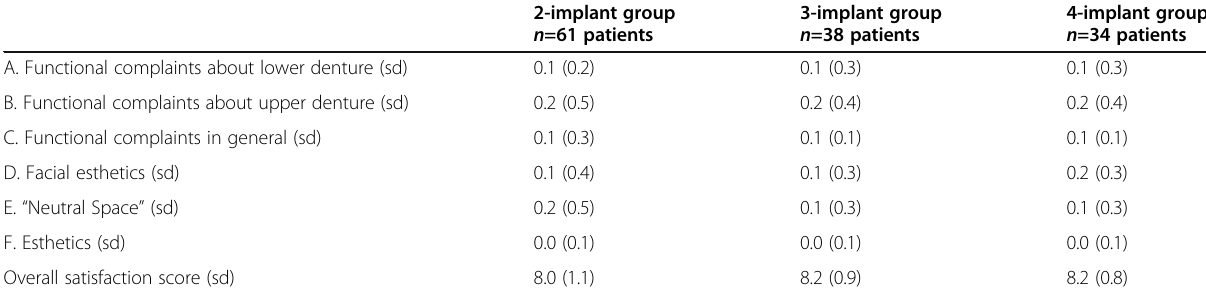
Table 3 Mean score of 6 scales concerning denture complaints (possible range 0 – 3) and overall satisfaction score (possible range 1 – 10) at the time of the follow-up appointment